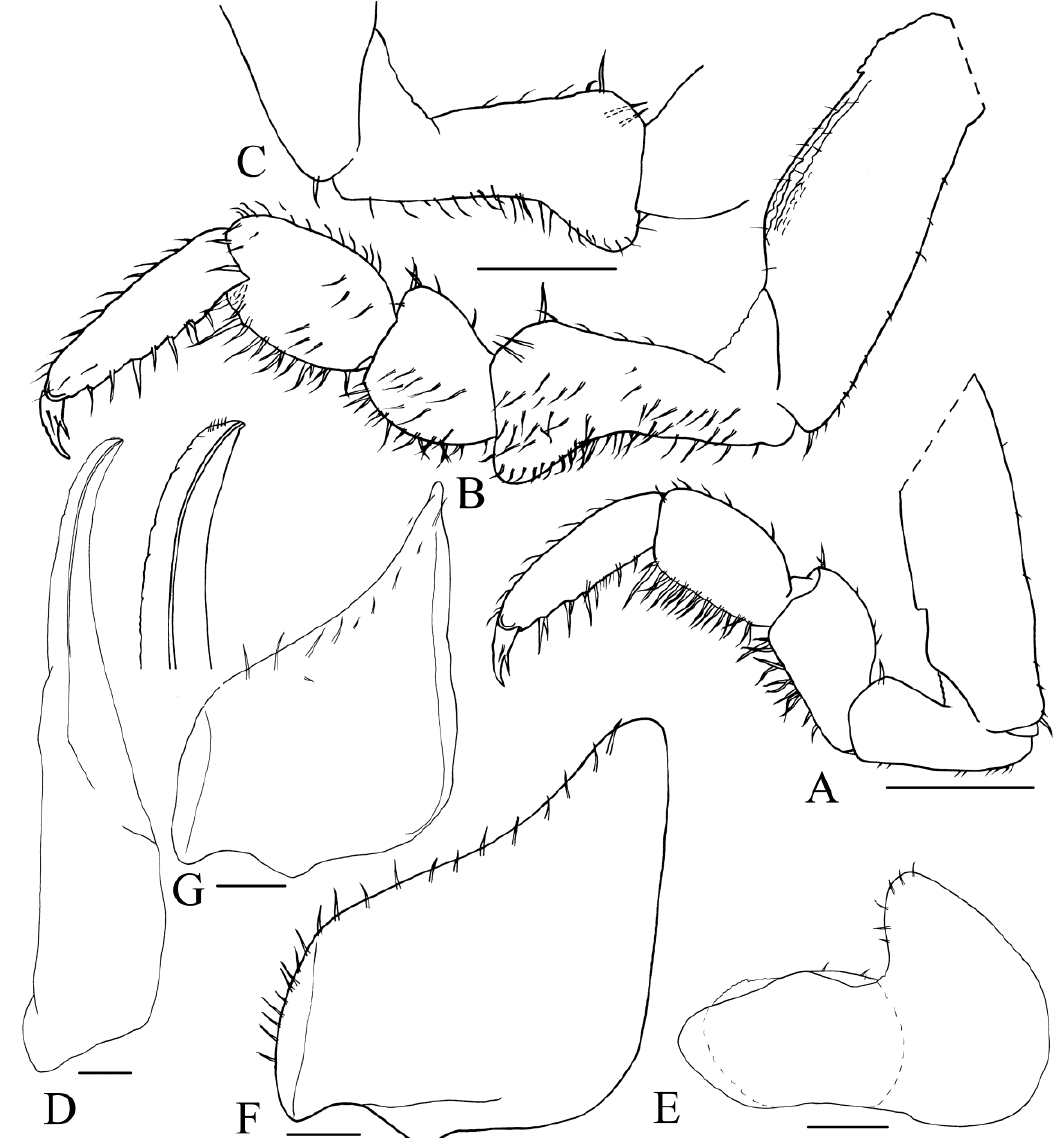
F IGURE 3. Schizidium golovatchi , male. A, pereopod I; B, pereopod VII, rostral view; C, pereopod VII ischium, caudal view; D, pleopod endopodite I; E, pleopod exopodite I; F, pleopod exopodite IV; G, pleopod exopodite V. Scales: A-C, 0.2 mm; D-G, 0.1 mm. Family Armadillidiidae Brandt, 1833 Material examined : Ardabil , Meshkin-Shahr to Pars-Abad, Ziveh, 39° 09' N, 47° 37' E, elev. 480 m, 17.6.2008, leg. G. M. Kashani, det. H. Schmalfuss, two males, two females (IRIPP Iso-1069); same data as before, eight males, thirteen females (PCGMK 1233); Neer, Koorabbasloo village, 37° 57' N, 48° 03' E, elev. 1740 m, 17.4.2019, leg. F. Heydarnezhad, one male, two females (PCGMK 2729); 30 Km S Germi, 39° 00' N, 47° 54' E, elev. 920 m, 17.4.2019, leg. F. Heydarnezhad, one male, one female (PCGMK 2751); Khalkhal, Hashtjin, 37° 15' N, 48° 25' E, elev. 740 m, 1.4.2019, leg. F.